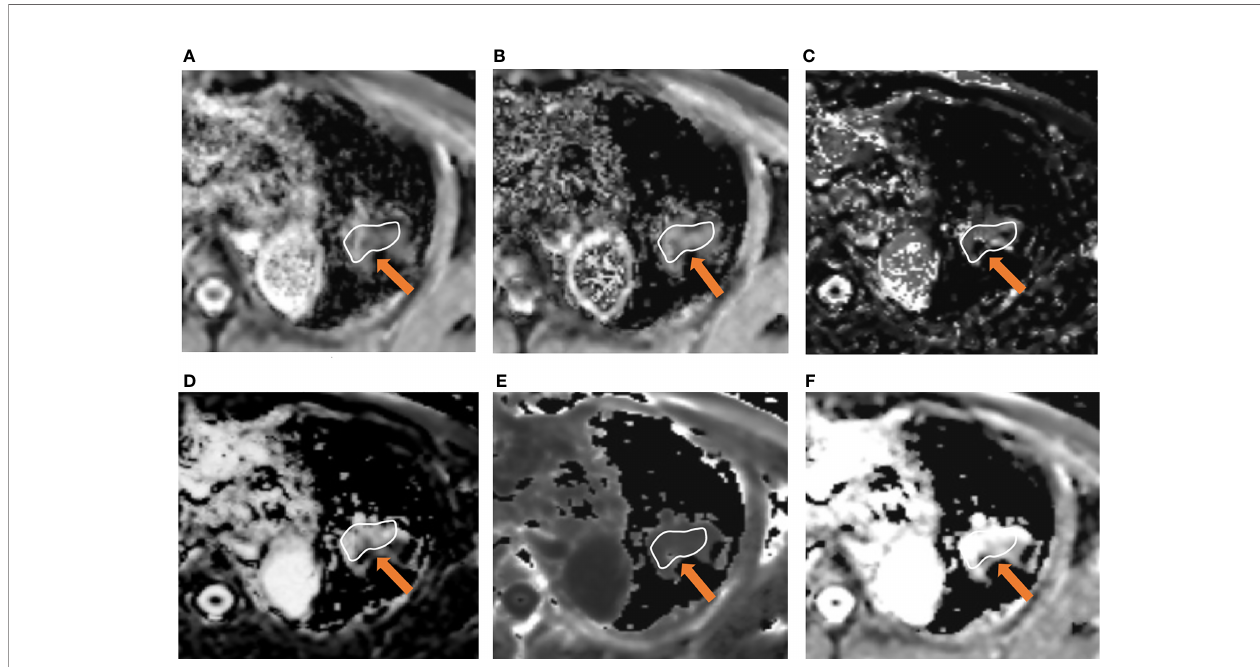
FIGURE 3 | A 66-year-old male was diagnosed with lung adenocarcinoma in the left upper lobe. Parameter map of ADC, D, D*, f, Kapp, and Dapp calculated from multiple b-value DWI data (A – F) . The calculated mean values of ADC, D, D*, f, Kapp, and Dapp were 0.84×10 -3 mm 2 /s, 0.65×10 -3 mm 2 /s, 35.23×10 -3 mm 2 /s, 32.31%, 1.01, and 2.21×10 -3 mm 2 /s, respectively.